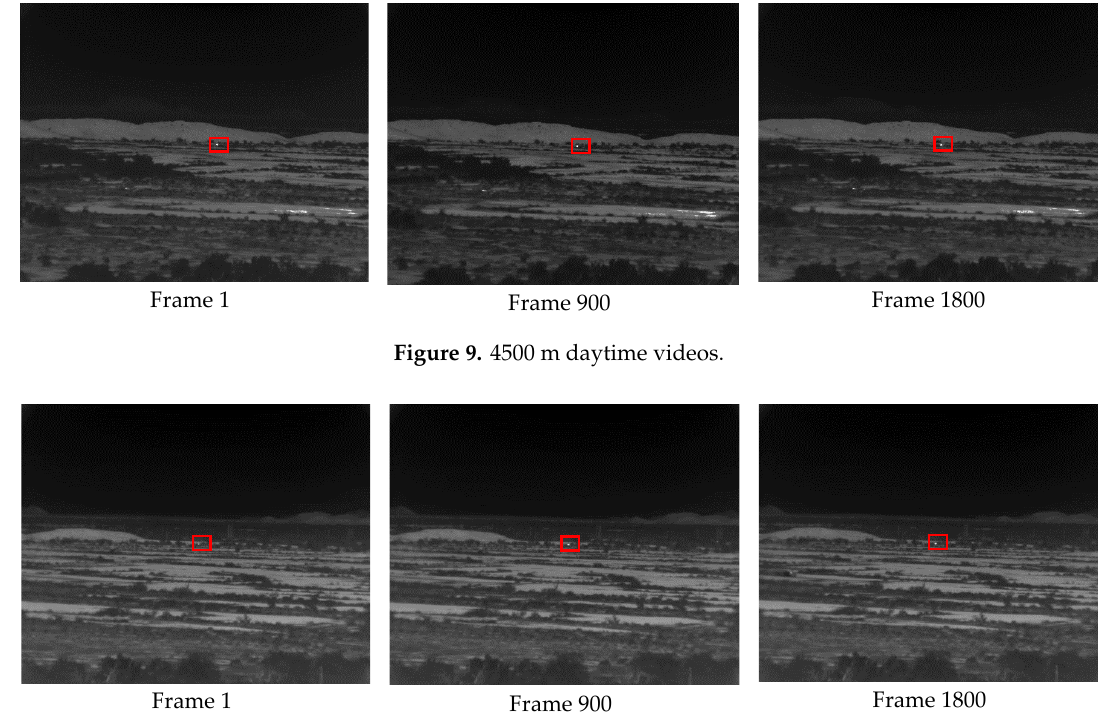
Figure 10. Frames from the 5000 m video.